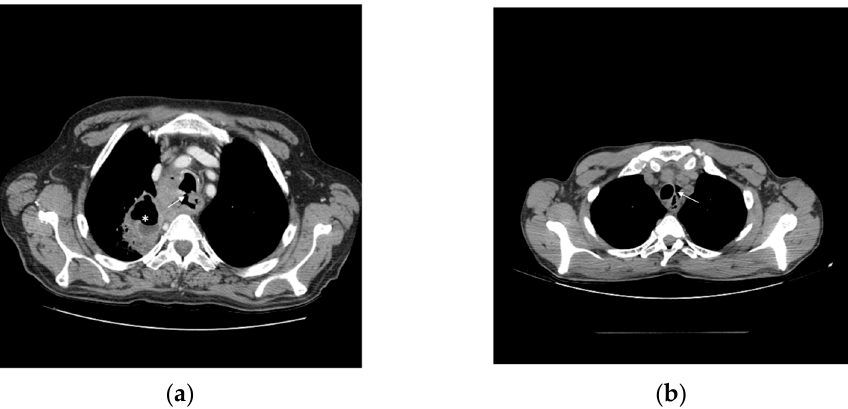
Figure 2. Oesophageal fistula. ( a ) Tracheo-oesophageal fistula (arrow) associated with pneumonia and lung abscess (*) ( b ) Squamous carcinoma of cervical oesophagus complicated with pneumome- diastinum (arrow).